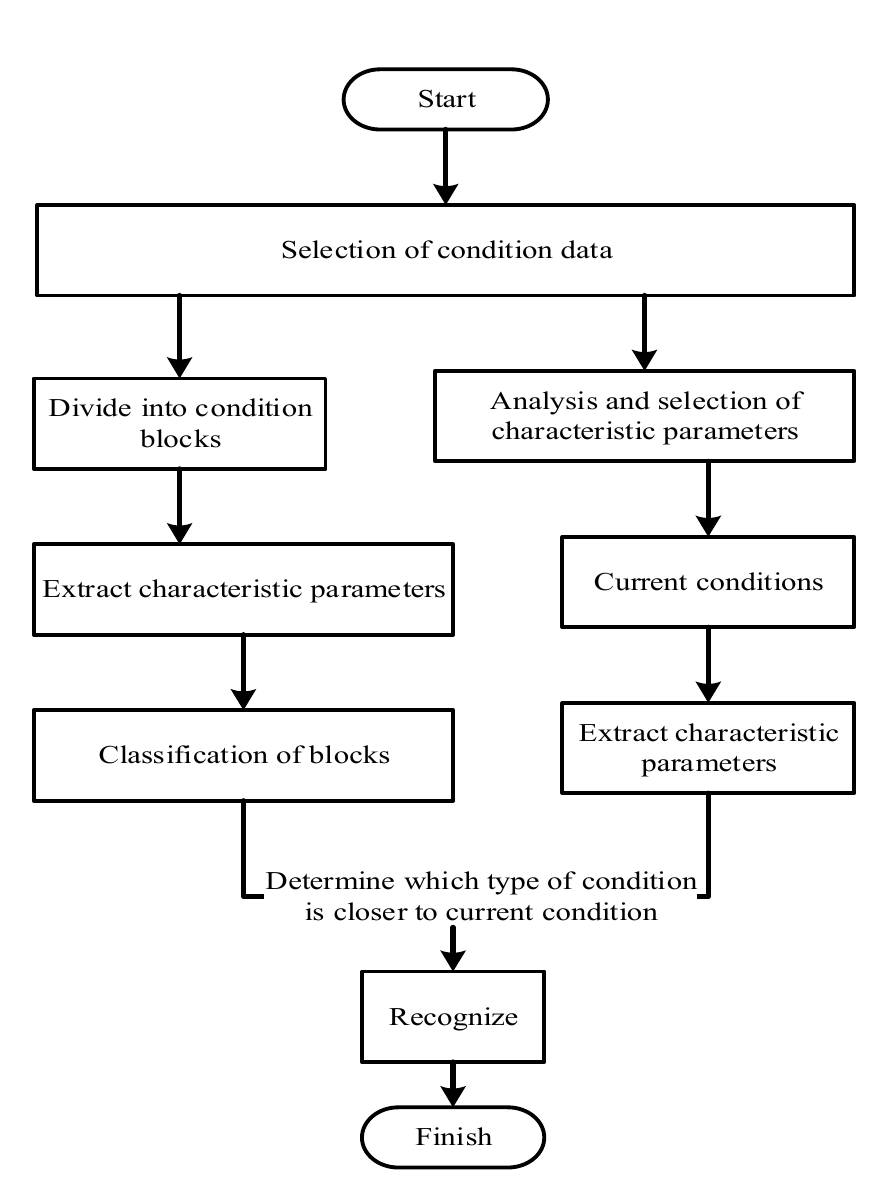
Figure 4. Flow chart of condition recognition.